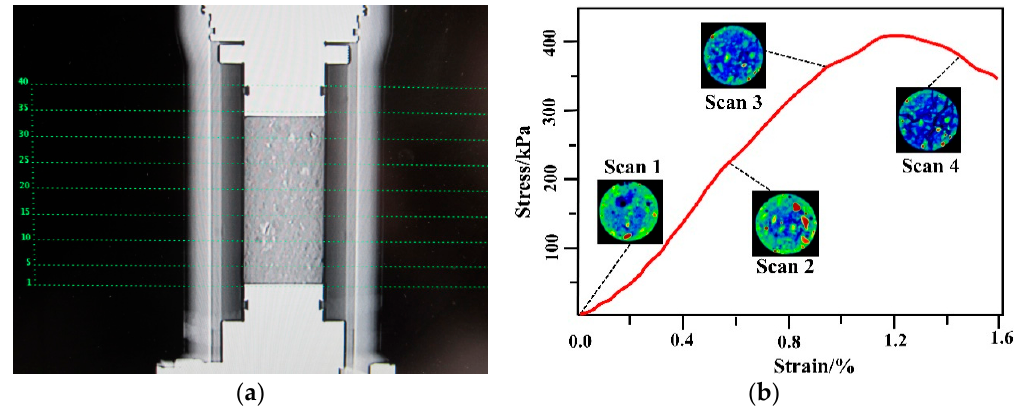
Figure 5. Determination of scanning layers and scanning points. ( a ) Determination of scanning layers; and ( b ) determination of the scanning spots.